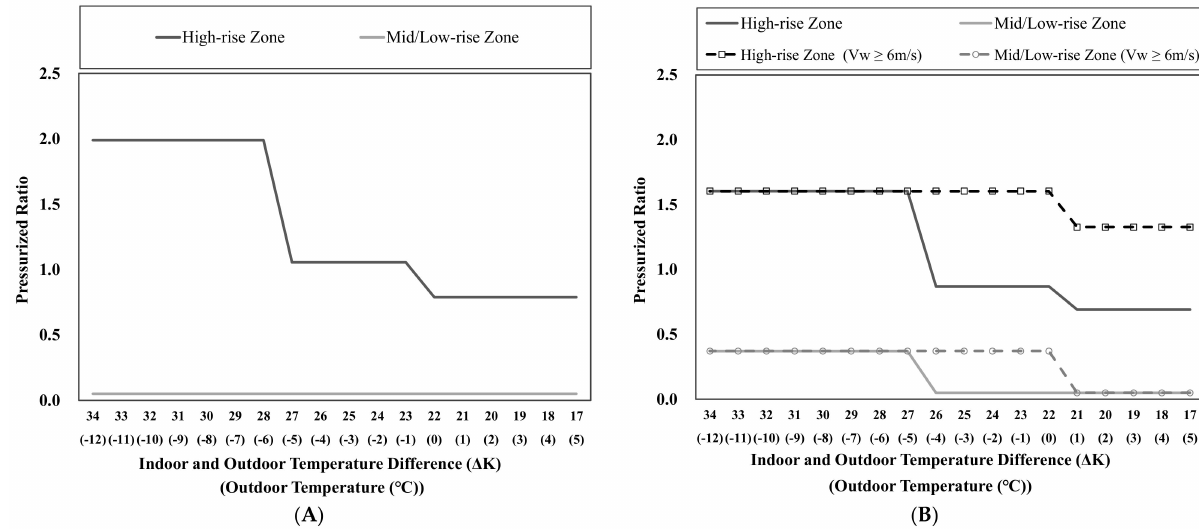
Figure 9. ( A ) Pressurized ratio in mode 3 based on outdoor air temperature for each zone in winter 2014. ( B ) Pressurized ratio in mode 4 based on outdoor air temperature and wind velocity for each zone in winter 2015.